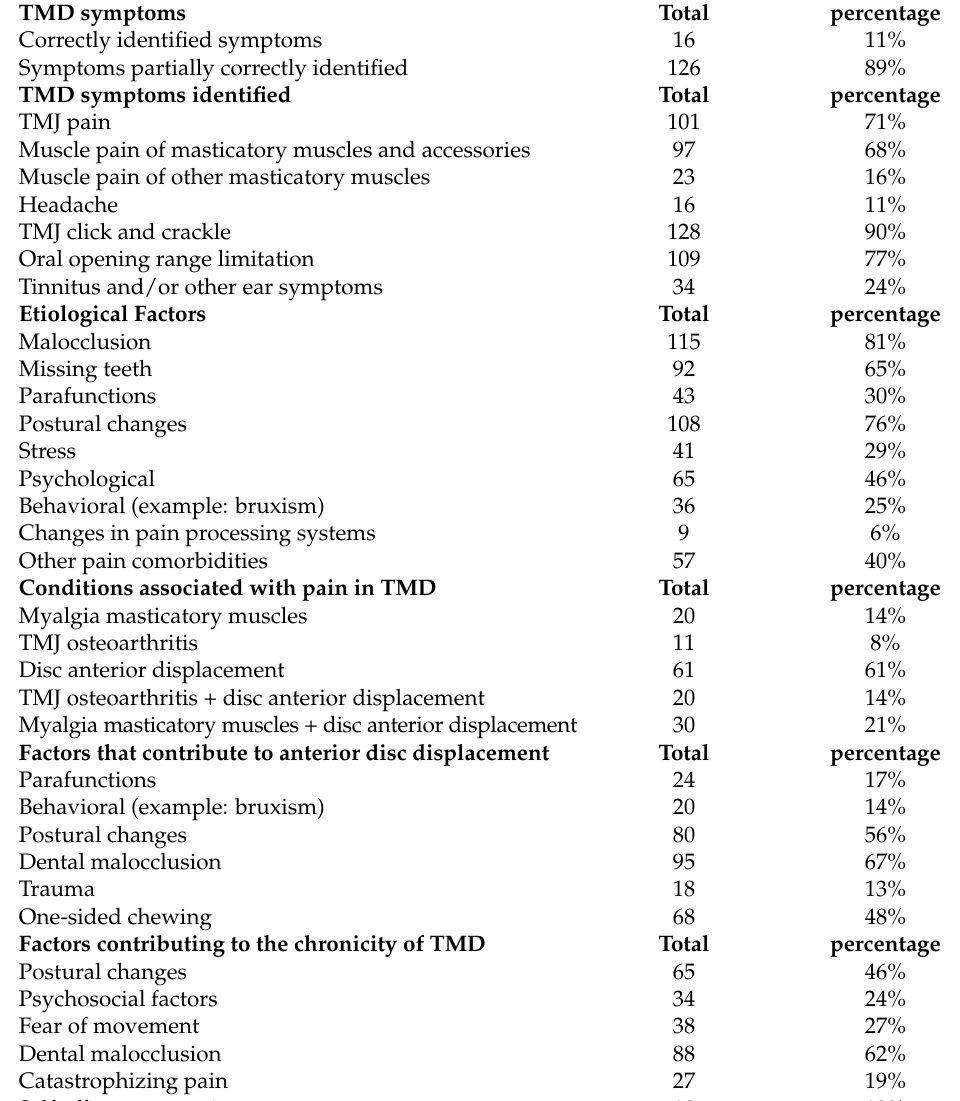
Table 2. Self-perception of the knowledge of physiotherapists in the treatment of TMD ( n = 142).